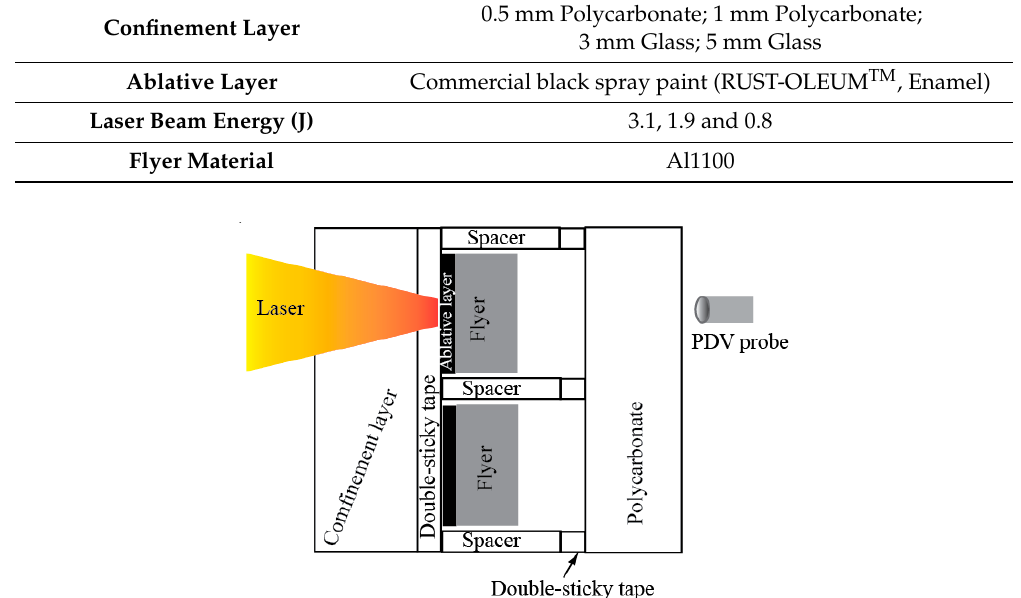
Table 1. Experimental parameters.